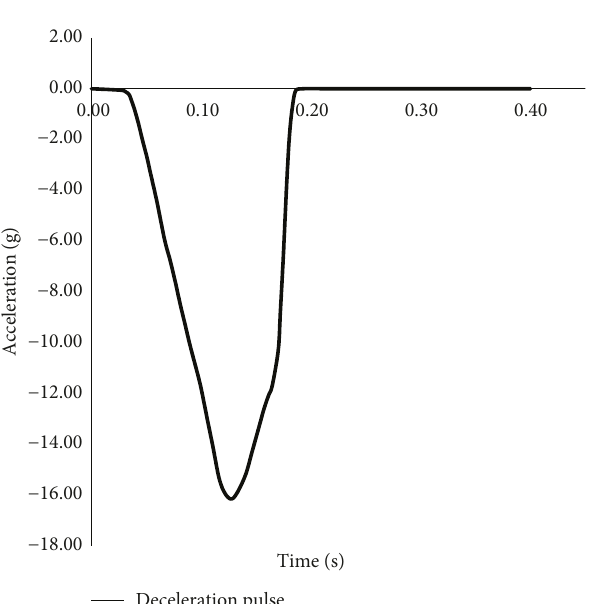
Figure 2: Resultant deceleration versus time curve characterizing the seat sled